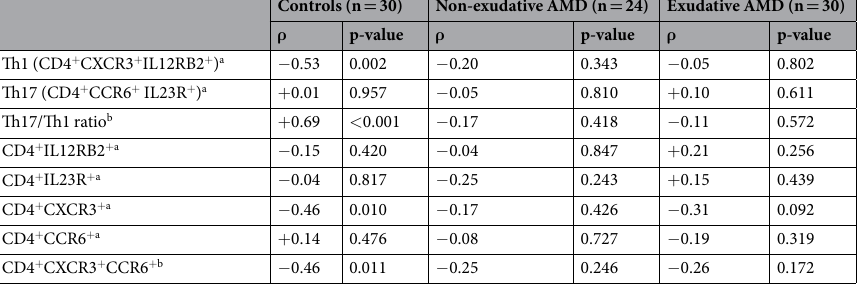
Table 3. Correlations between increasing age and CD4 + T-cells surface proteins are present in control individuals (CD4 + CXCR3 + , CD4 + CXCR3 + IL12RB2 + , and CD4 + CXCR3 + CCR6 + ), but not in patients with non-exudative or exudative age-related macular degeneration (AMD). Abbreviations: n = number; AMD = age- related macular degeneration; Th1 = T helper 1; Th17 = T helper 17. Correlation coefficients ( ρ ) and p-values are calculated using: a Pearson’s correlation; b Spearman’s correlation. Cell populations with significant differences are greyed out.